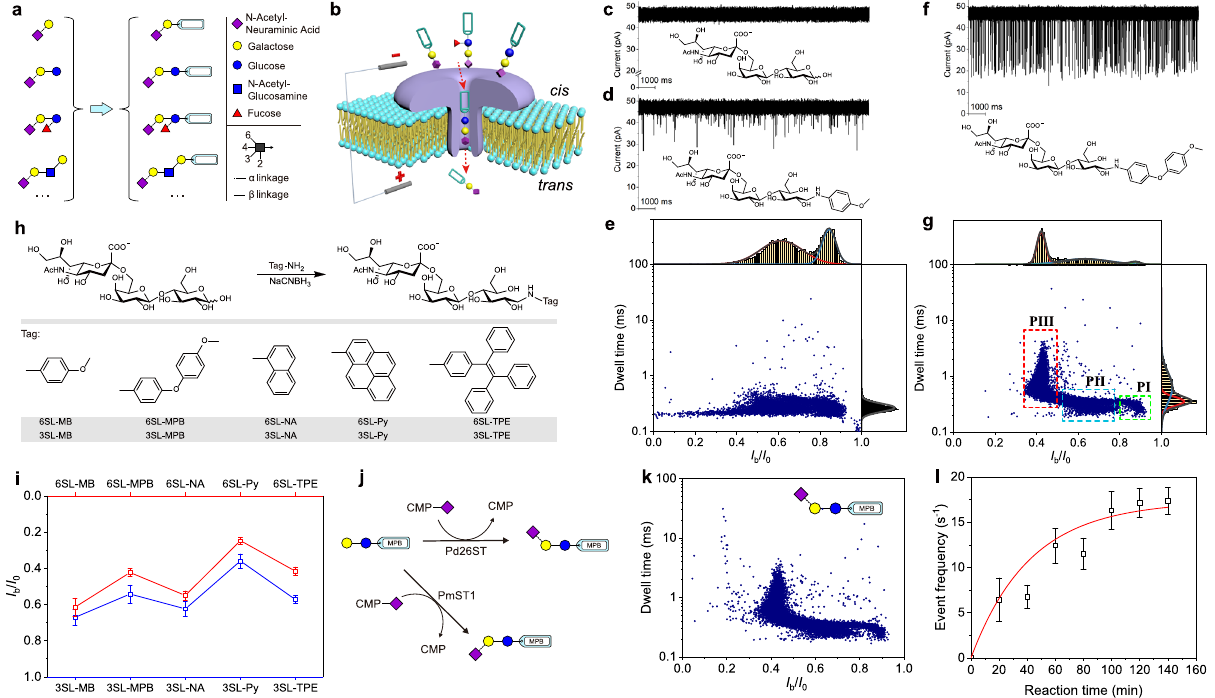
Fig. 1 | Nanopore-based glycan detection. a Schematic showing derivatization of glycans depicted with Symbol Nomenclature for Glycans (SNFG) 51 . b Schematic of translocation of tagged glycans through AeL nanopore. Representative ionic cur- renttracesfrom6 ′ -sialylactose(6SL)( c ),1-methoxybenzene(MB)-tagged6SL(6SL- MB)( d ),1-methoxy-4-phenoxybenzene (MPB)-tagged6SL(6SL-MPB)( f ),andevent scatterplotsof6SL-MB( e )and6SL-MPB( g ).ThepopulationsofPI,PIIandPIIIinthe scatter plot of g are shown by the colored boxes. The I b / I 0 and logarithmic dwell time were fi tted to multiple or single peak Gaussian distributions. h Schematic of glycan derivatives with different tags and the corresponding short names. i , I b / I 0 values of the characteristic populations of glycan (6SL and 3SL) derivatives with different tags, including MB, MPB, naphthyl (NA), pyrene (Py), and tetra- phenylethylene (TPE). Each data represents the mean value of I b / I 0 , and the